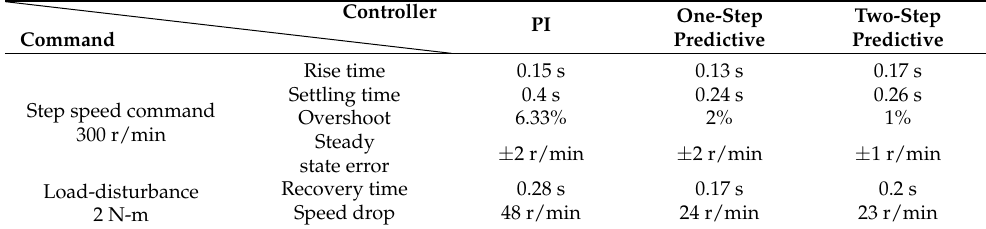
Table 3. Comparison of speed